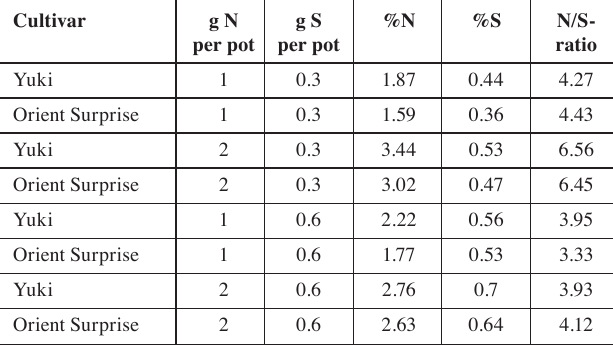
Tab. 1: Percentage of N, S and N/S-ratio in shoots of Chinese cabbage.